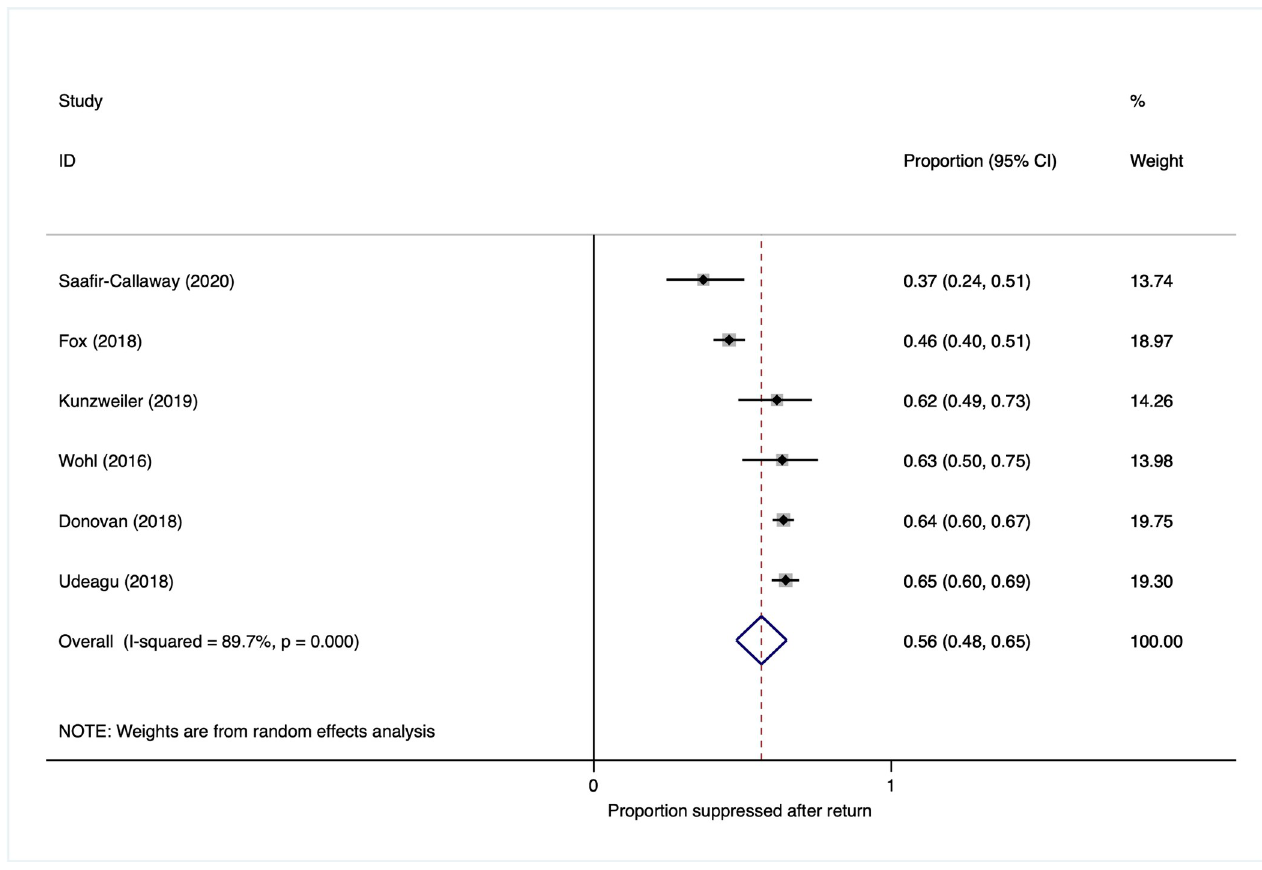
Fig 9. Proportion virally suppressed after return to